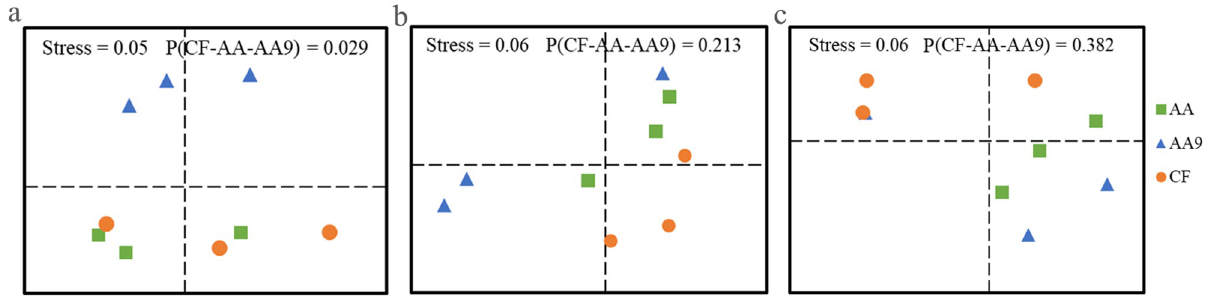
Fig 3. Bacterial and fungal composition. NMDS result showed the bacterial (a, with Bacillus ; c, without Bacillus ) and fungal (b) microbial community compositions of the different treatments. CF, treatment sprayed with chemical fertilizer; AA, treatment sprayed with amino acids liquid fertilizer; AA9, treatment sprayed with liquid biological fertilizer. The P value was calculated through AMOVA.